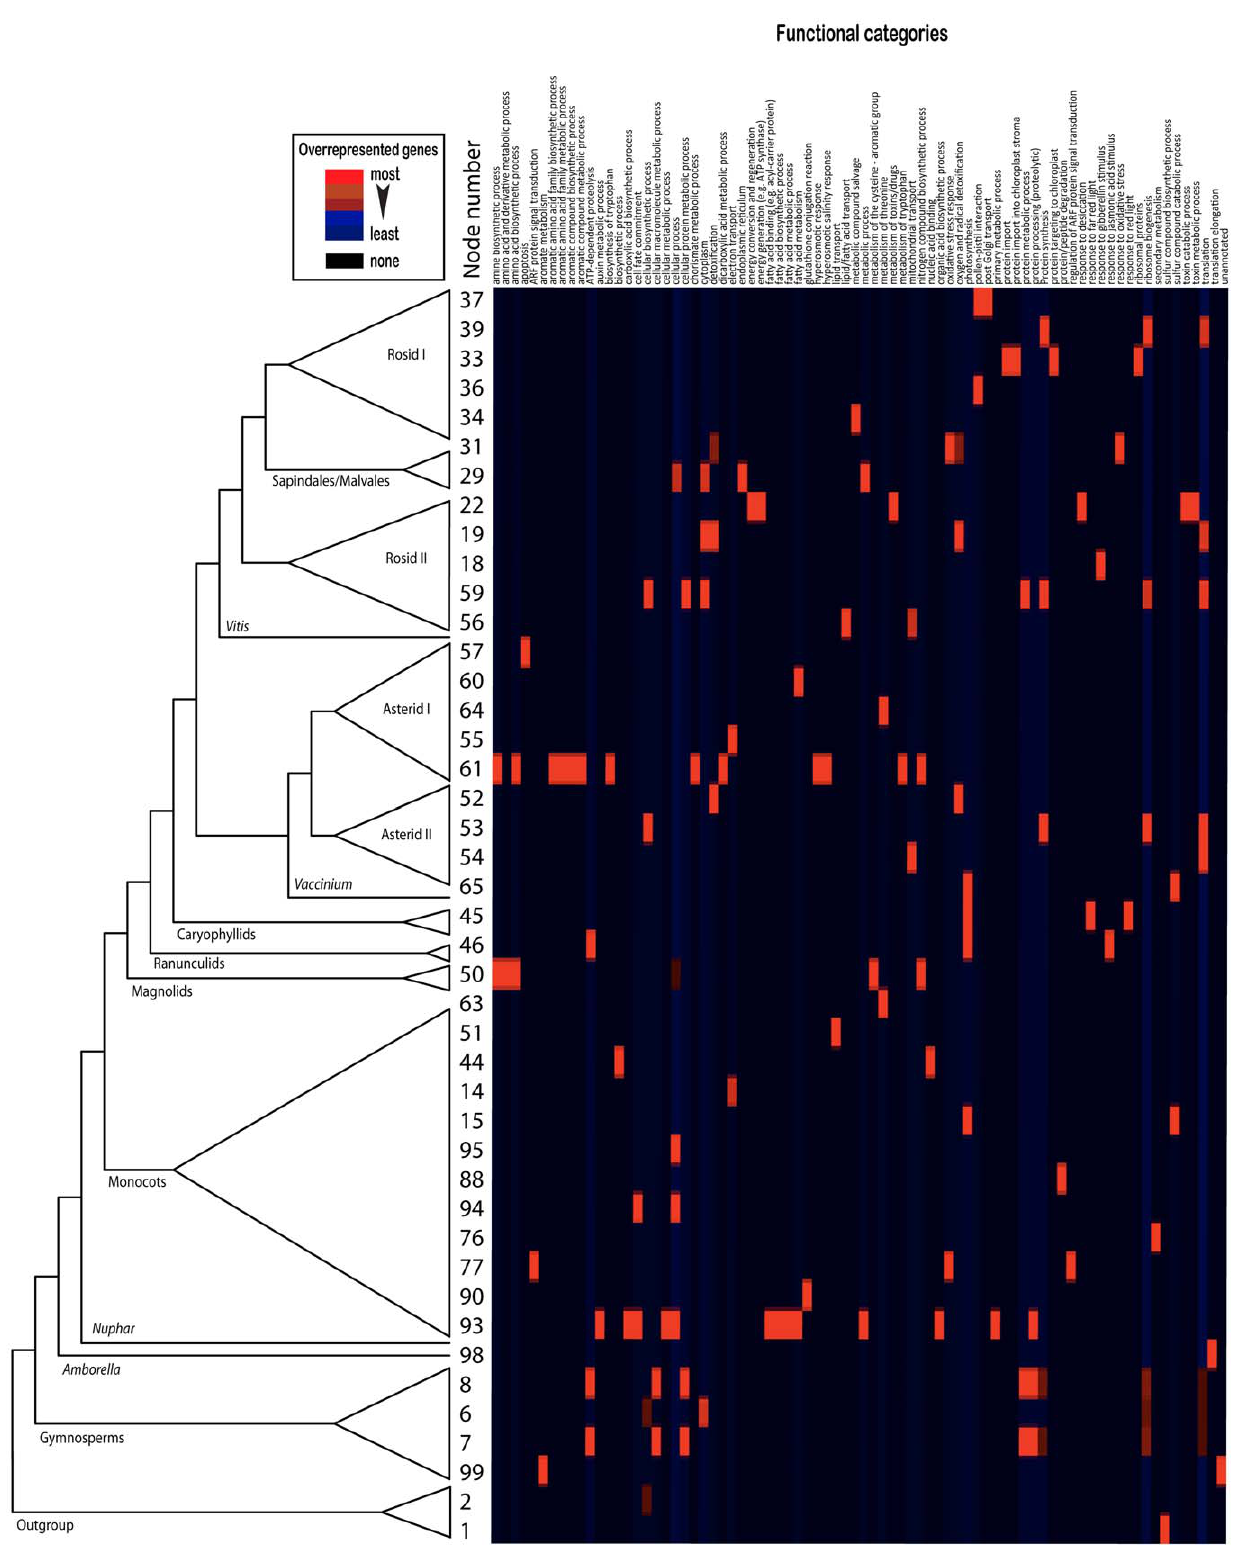
Figure 3. Distribution Map of Overrepresented GO Terms per Node. Each GO/MIPs category is shown in the upper axis. Color gradients show differences in proportions of these genes, with red being the category with the highest counts, light blue the least counts, and black with no match to any category. Overrepresentation is estimated on per-node basis. The reference tree is based on the MP-30 phylogenetic tree, and can be used to locate the relative position of a node represented by a heatmap row. The node numbering here corresponds to the node labels in Figure S7. Heat map constructed based on the Arabidopsis genome (source: http://noble.gs.washington.edu/prism – accessed on February 2009). doi:10.1371/journal.pgen.1002411.g003 PLoS Genetics | www.plosgenetics.org 7 December 2011 | Volume 7 | Issue 12 |